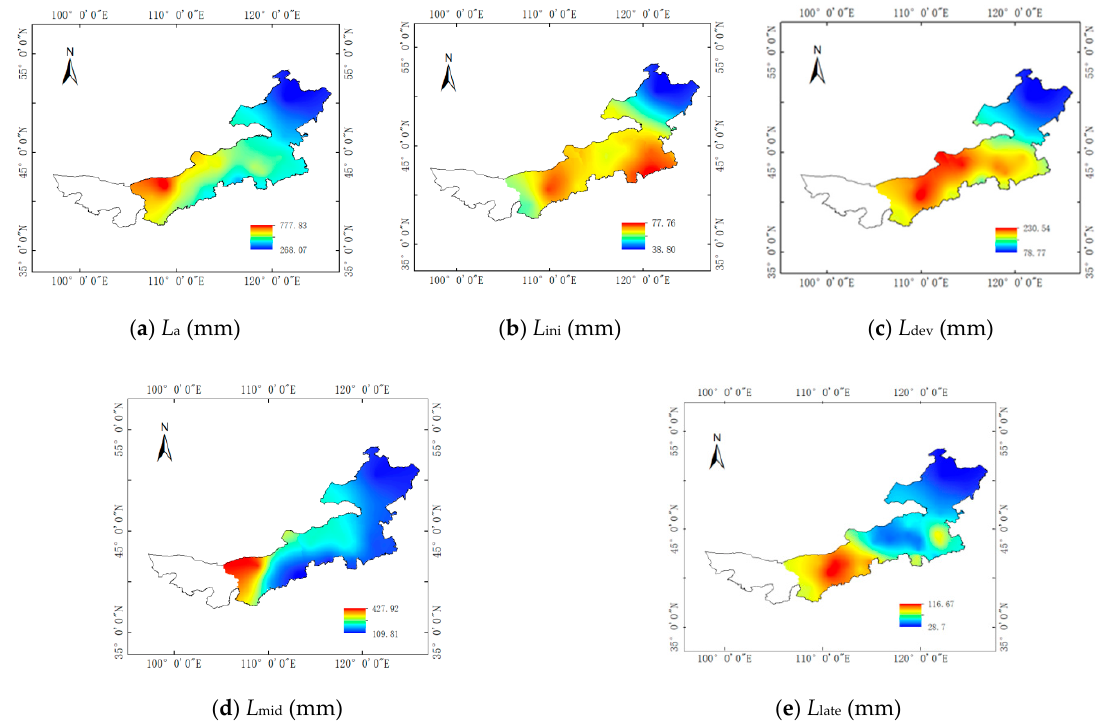
Figure 5. Spatial variation characteristics of ET c during the entire growth period ( a ), early growth period ( b ), rapid growth period ( c ), middle growth period ( d ), and end growth period ( e ) of maize from 1959 to 2018.